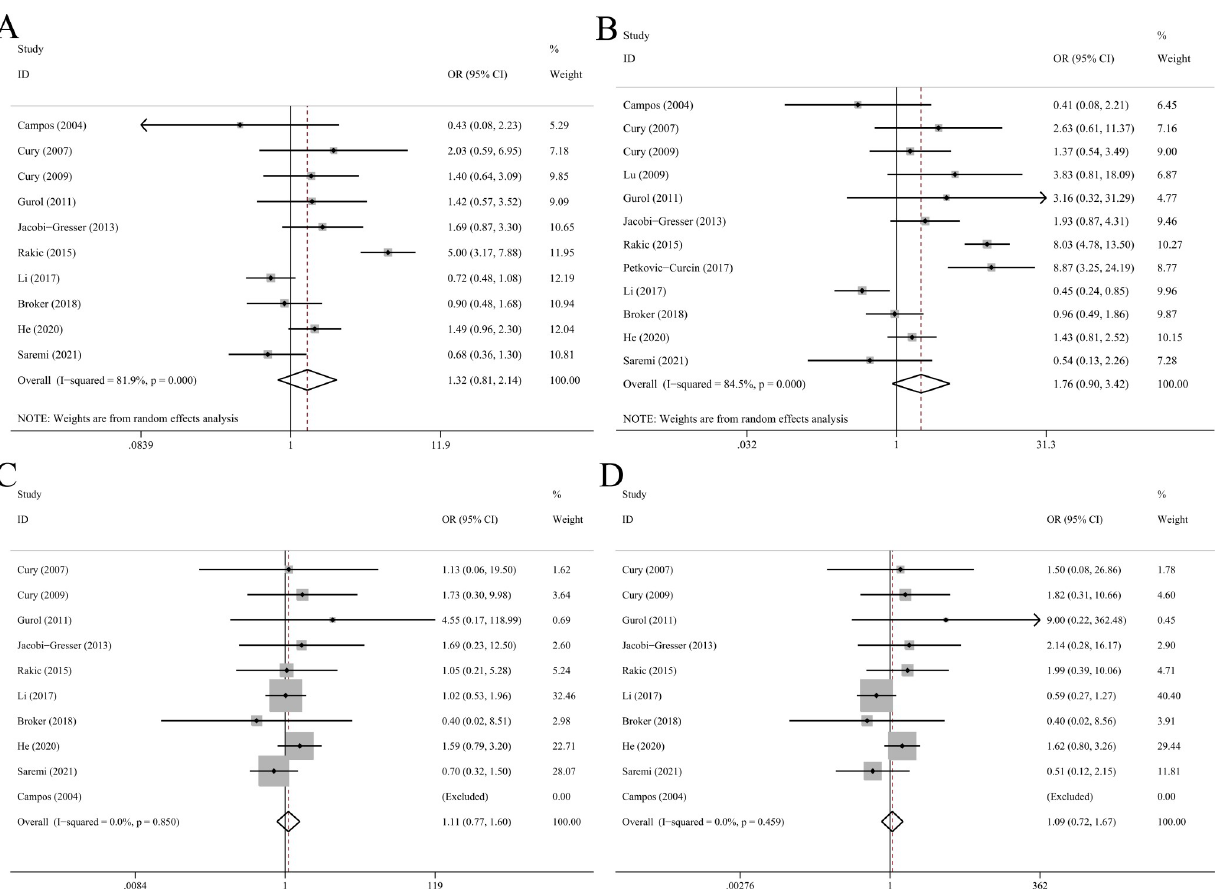
Fig 5. Forest plots of TNF α G-308A polymorphism with peri-implant disease risk in allelic (A), dominant (B), recessive (C) and homozygote model (D).